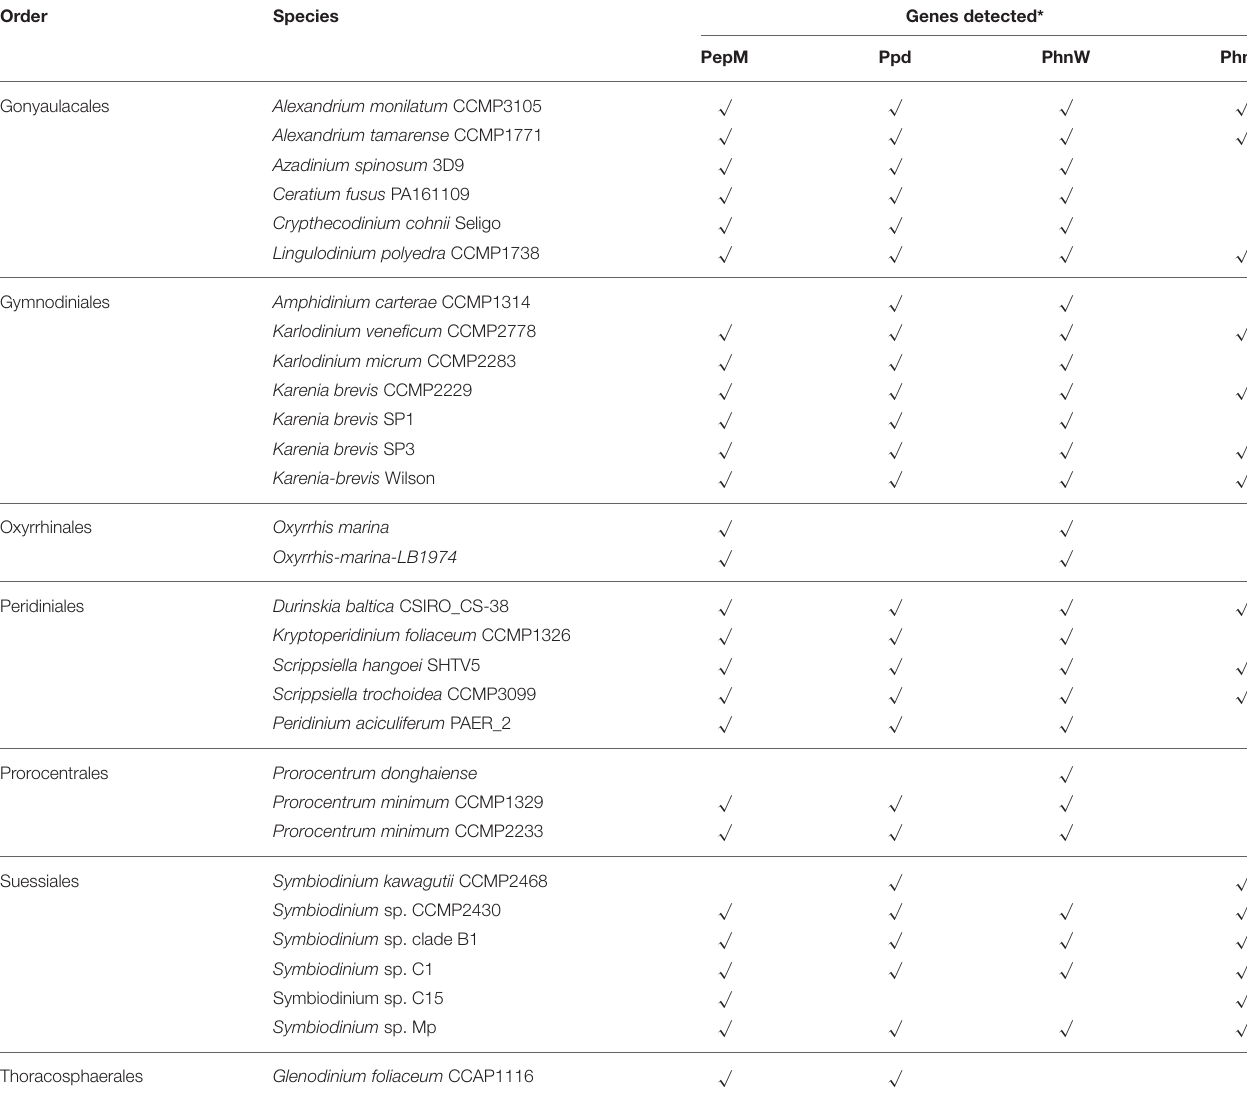
TABLE 1 | Genes related to phosphonate metabolism detected from available transcriptomes in dinoflagellates.